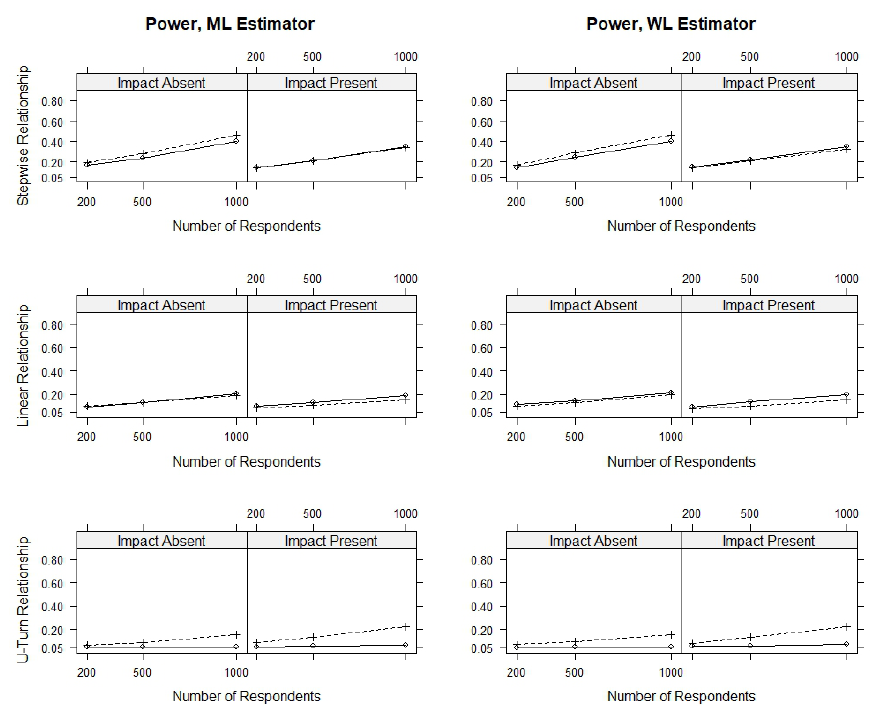
Figure A2. Power of two tests against unbalanced DIF in the β parameter for modules of 9 items. All items are used for ability estimation. The unbroken line presents the results for the linear logistic regression test, the broken line presents the results for the score-based bootstrap